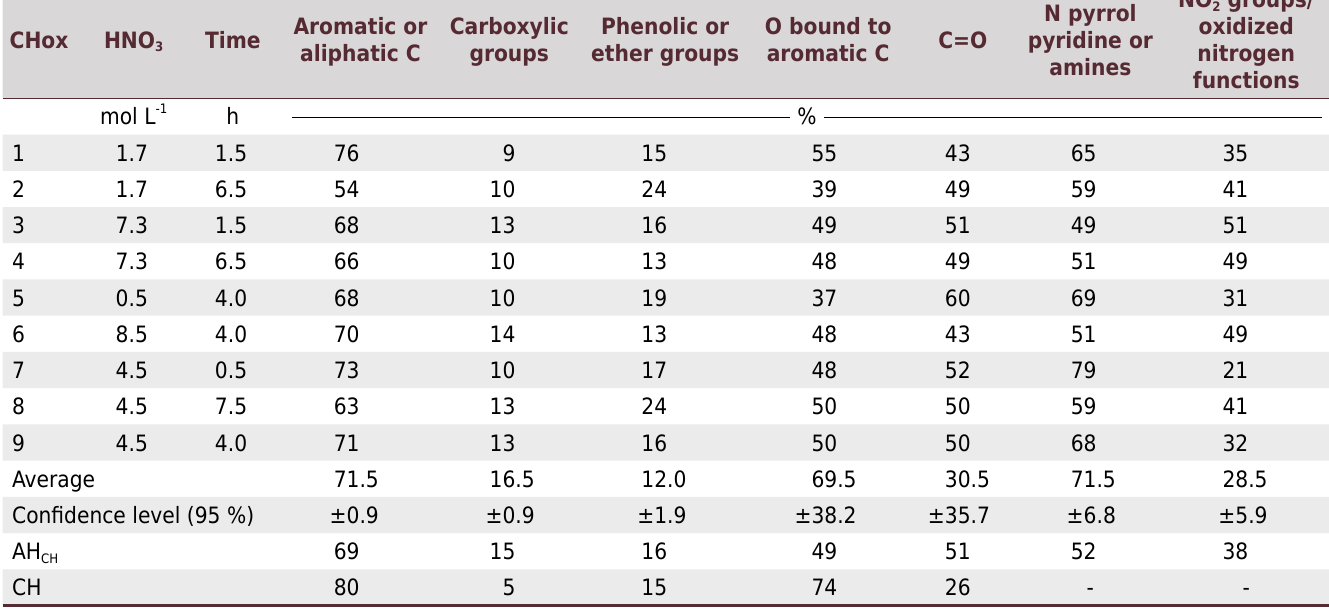
Table 4. Relative proportions of the surface chemical species of C, O, and N, identified by the XPS spectra of C 1s, O 1s, and N 1s, respectively, in CHox according to the concentration of HNO 3 and the reaction time, for humic acids obtained from charcoal (AHc H ) and eucalyptus charcoal (CH)